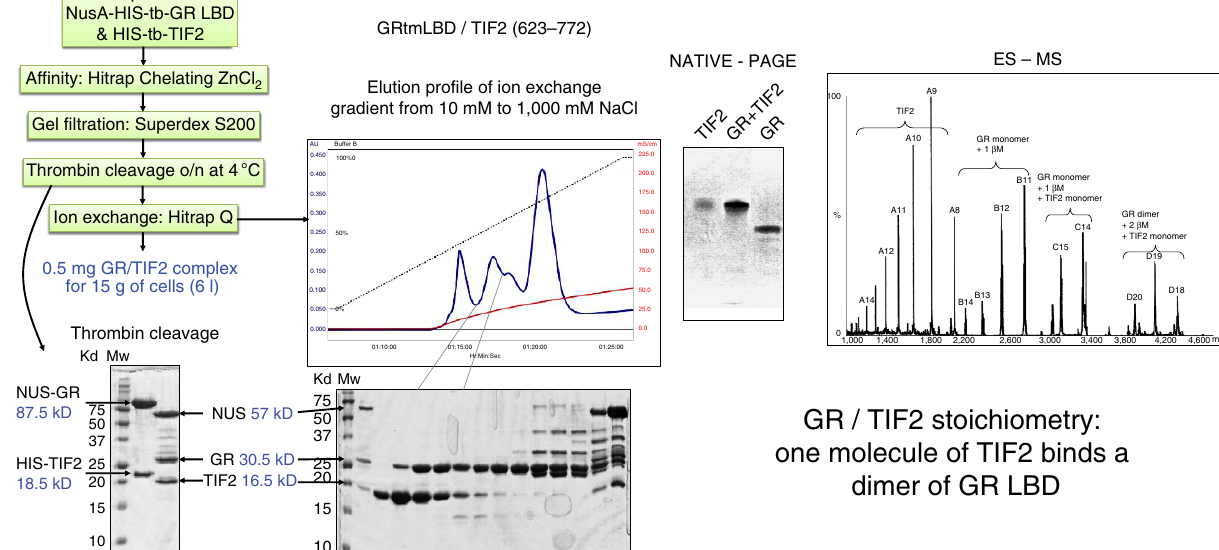
Figure 4 | Production and characterization of the GR/TIF2 (623–772) complex. The complex was produced by co-expression of the two proteins in the same cell. After affinity chromatography and gel filtration the tags were removed by thrombin cleavage followed by ion exchange chromatography. The fractions containing the complex were used for native PAGE and ES-MS. The ES-MS spectrum shows the presence of unfolded TIF2 (623–772) (poly- charged species), monomers of GR, monomer and dimer of GR bound to one molecule of TIF2. The transition from a poly-charged species of TIF2 to structured TIF2 when bound to GR indicates that the GR induces the folding of the co-activator molecule upon GR